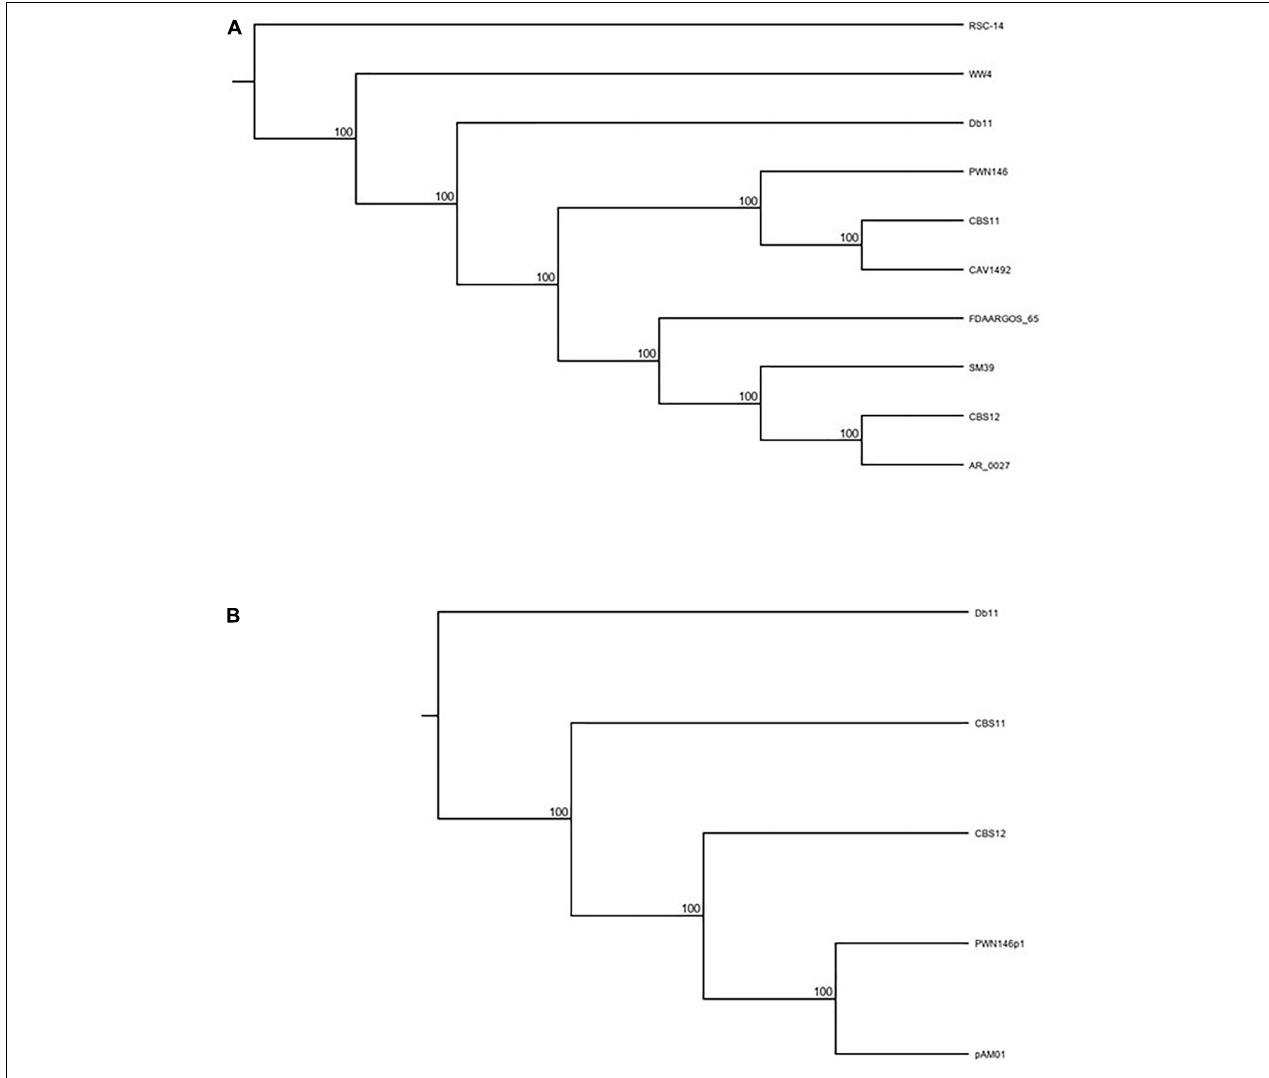
FIGURE 1 | Tamura Nei Phylogenetic rooted tree (cladogram format) analyses of (A) CBS11 and CBS12 along with eight other known S. marcescens strains [RSC-14 (outgroup), Db11, SM39, CAV1492, WW4, FDAARGOS_65, AR_0027, PWN146]; and (B) pAM01 along with S. marcescens strains [CBS11, CBS12, Db11 (outgroup)] and S. marcescens plasmid PWN146p1. See text for further